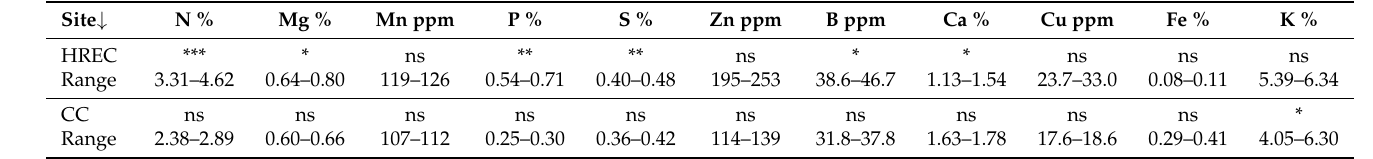
Table 5. Differences in mineral nutrient content of spinach tissues grown under four fertility treat- ments at two sites.